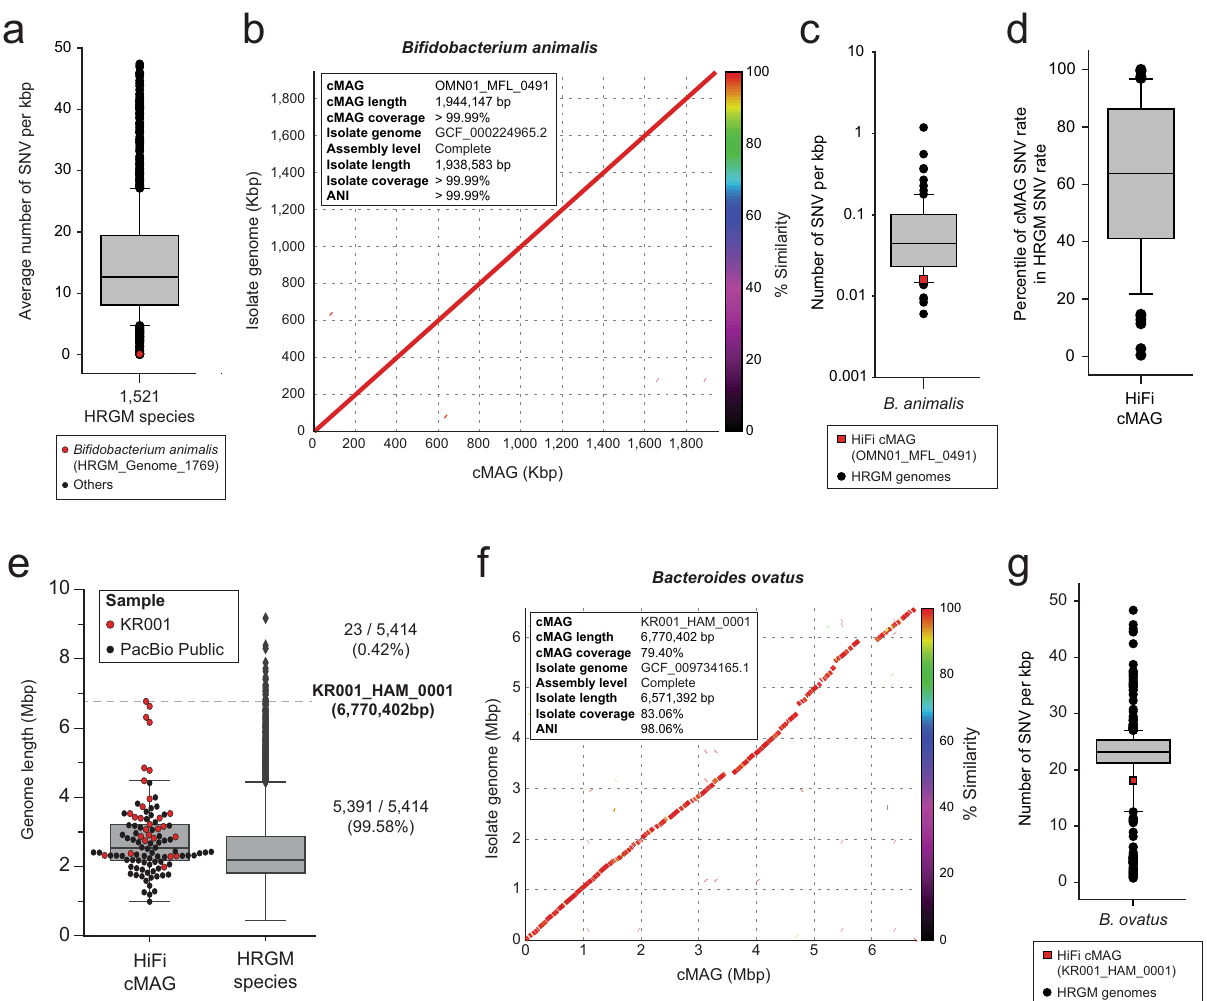
Fig. 2 | HiFi metagenomic sequencing reconstructs accurate and long prokar- yotic genomes. a Single nucleotide variation (SNV) rate of HRGM species ( n =1521) and Bi fi dobacterium animalis (red dot). b Genome alignment plot between B. animalis cMAG ( x -axis) and the closest isolated genome ( y -axis). c SNV rate of B. animalis cMAG and its conspeci fi c HRGM genomes ( n =102). d Percentile rank SNV rate of cMAGs ( n =77) among conspeci fi c genomes. e AssembledgenomelengthofcMAG( n =102)andHRGM( n =5414)species.The